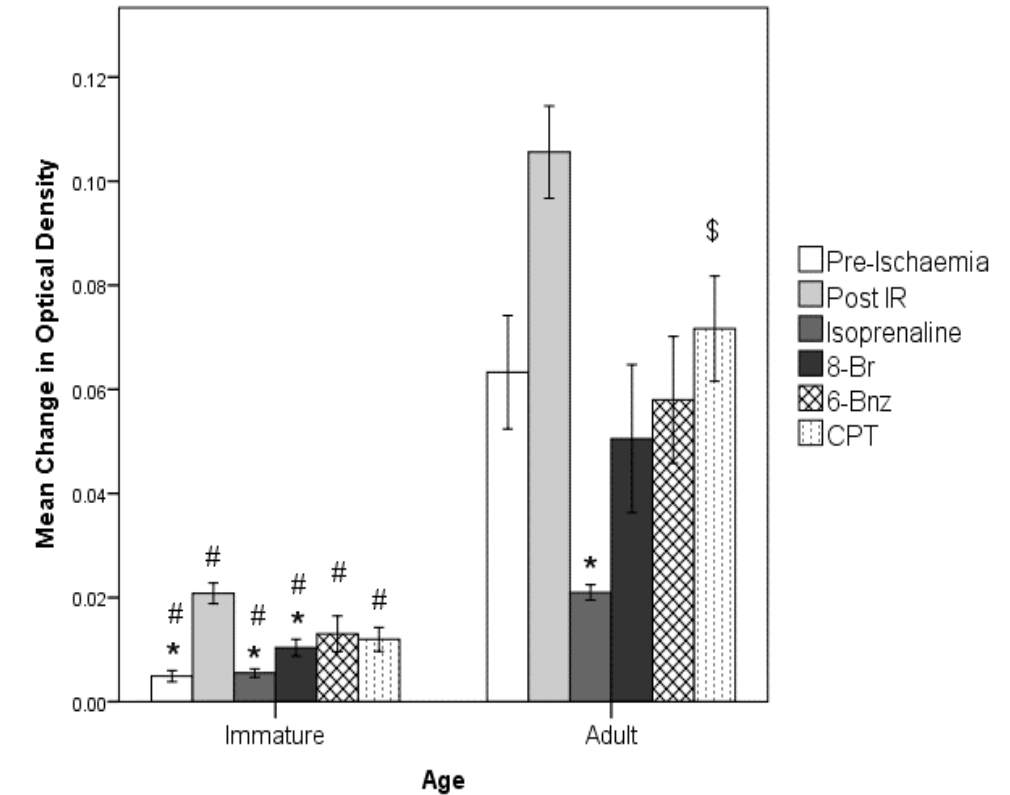
Figure 6. Summary of effects of interventions on MPTP activity. Error bars = 1 SEM. * = p < 0.05, vs. IR group in corresponding age group. # = p < 0.05 vs. adult age group in corresponding intervention. $ = p < 0.05 vs. isoprenaline in corresponding age group. Significance testing by 2-way ANOVA. n = 6 per age group per drug